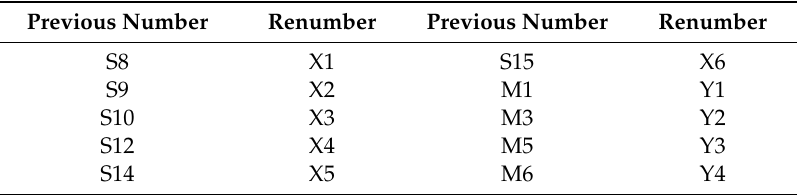
Table 4. Renumbering of the 10 screened FF sample batches.